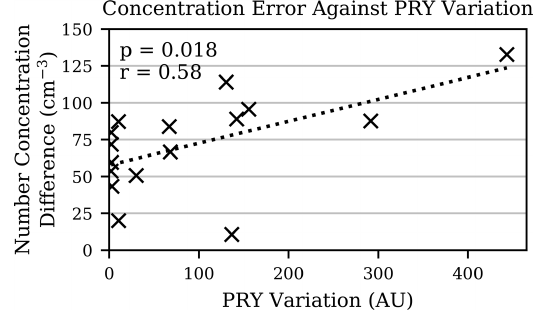
Figure 12. A plot of the difference in effective diameter between the station mounted UCASS and the UAV mounted UCASS over the progression of the campaign. The 2d discussed are highlighted in blue and orange.